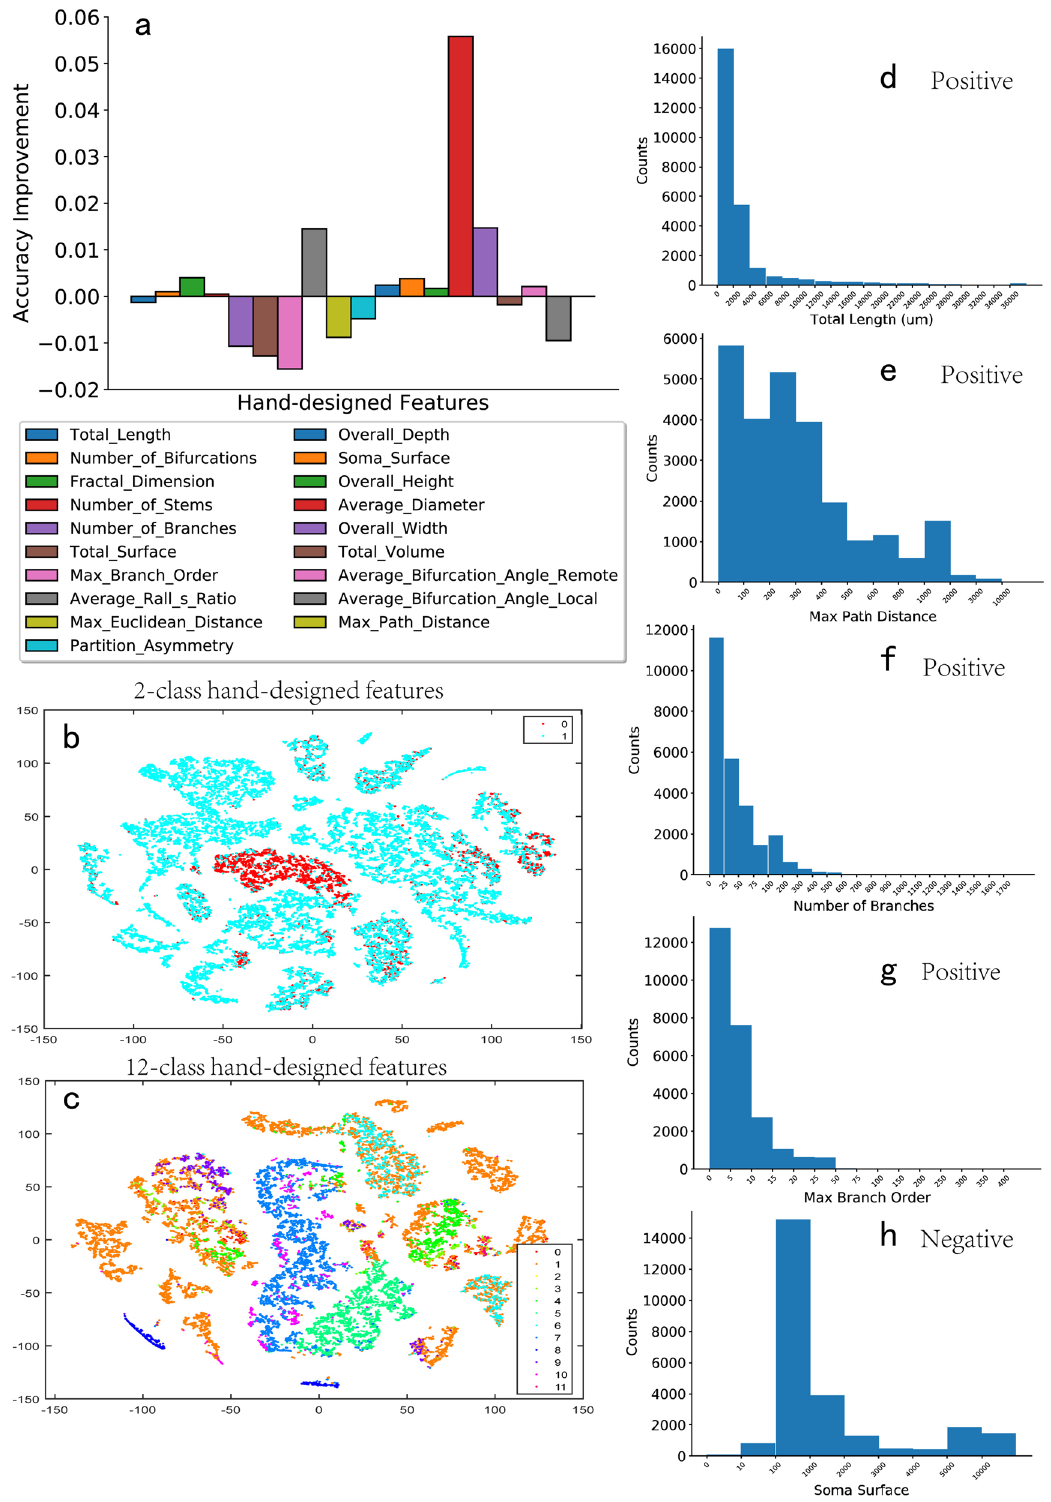
Figure 5. ( a ) Accuracy improvements of various hand-designed features. ( b ) The t-SNE distribution for the 2-class hand-designed features. ( c ) The t-SNE distribution for the 12-class hand-designed features. ( d , e , f , g ) Some positive hand-designed features for neuron type classification, including the total length, max path distance, number of branches, and max branch order. (h) Negative hand-designed